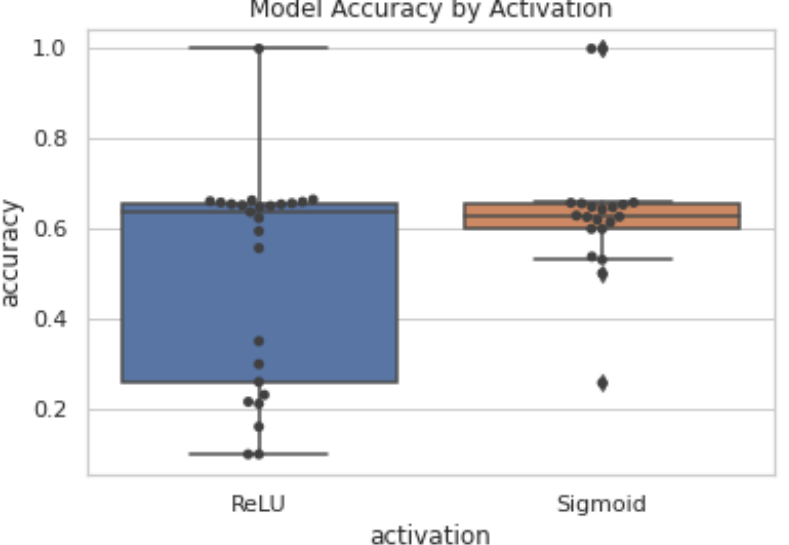
Figure 10. Model performance using different activation functions in the sphira network on the fashion-MNIST dataset. All activations here are their FHE-compatible approximations unless otherwise specified. Each dot is a different network or the same network with a different data type(cyphertext, plaintext)